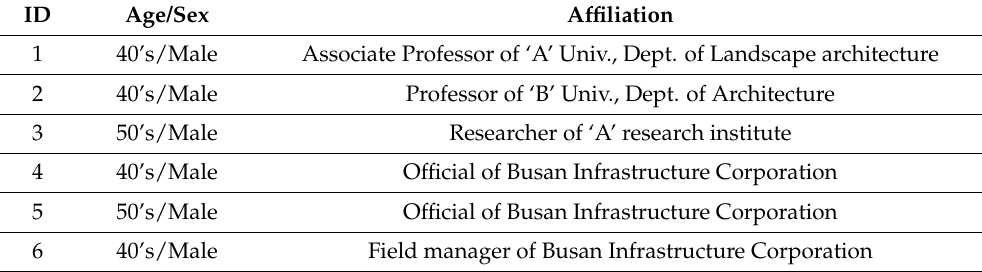
Table 1. Interviewee